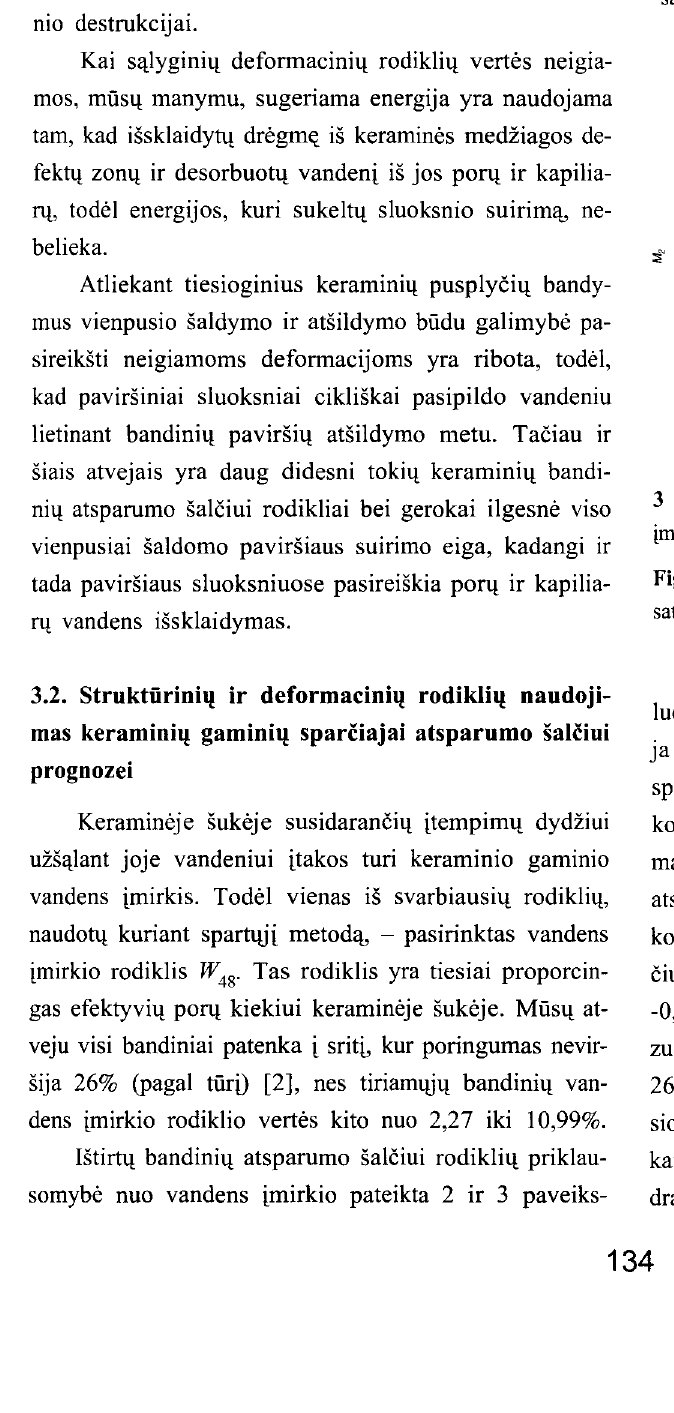
2 pav. Atsparumo salciui rodiklio priklausomybe nuo vandens imirkio. Tiesines regresijos lygis M1 =434,83-41,29W Fig 2. Relationship between frost resistance and water saturation. Regression equation M1 = 434,83-41,29 W